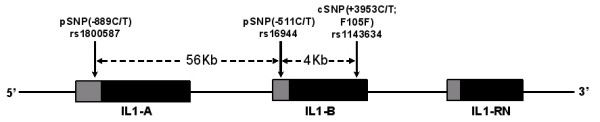
Location of the SNPs in IL1 gene cluster IL1 alpha, IL1 beta, IL1 receptor antagonist (RN). The promoter regions and coding sequences of the genes are shown in light and dark shaded boxes. The dbSNP refrence SNP ID for each SNP is provided. rs1800587 and rs16944 are located in the promoter (p) region of IL1A and IL1B, respectively while rs1143634 represents a synonymous SNP (F105F) in the coding (c) sequence of IL1B gene. The genomic distances between the SNPs are also shown.